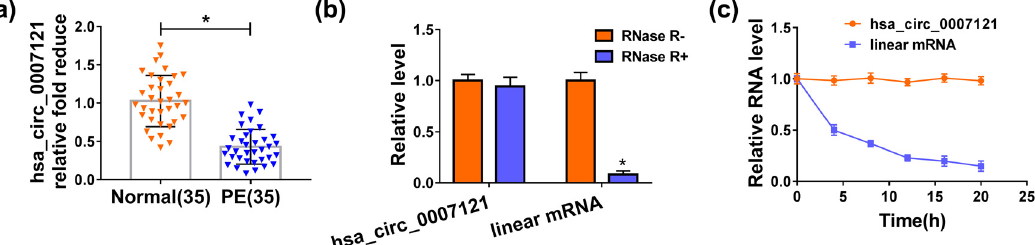
Figure 1: Hsa_circ_0007121 was downregulated in PE placental tissues. ( a ) The level of hsa_circ_0007121 in PE placental tissues ( n = 35 ) and normal placental tissues ( n = 35 ) was measured by qRT - PCR. ( b ) Hsa_circ_0007121 and the linear mRNA levels in HTR - 8/SVneo cells treated with or without RNase R were detected by qRT - PCR. ( c ) hsa_circ_0007121 and the linear mRNA levels in HTR - 8/SVneo cells treated with actinomycin D at the pointed time were checked by qRT - PCR. * P <